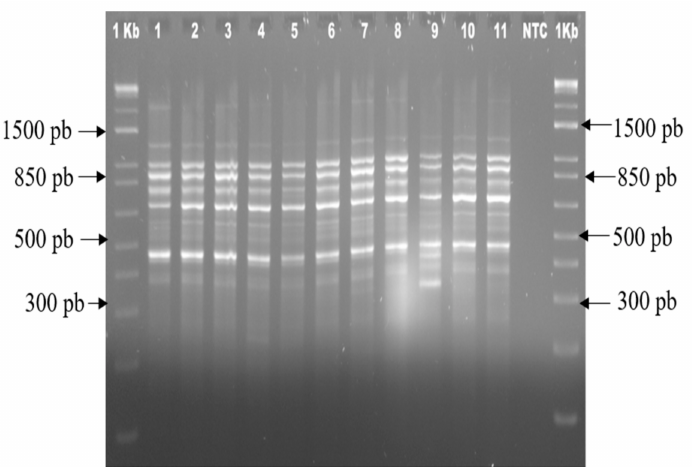
Figure 8. ISSR primer (IS 19) showed the highest number of bands. 1: Hybrid ‘MD2’ donor material;